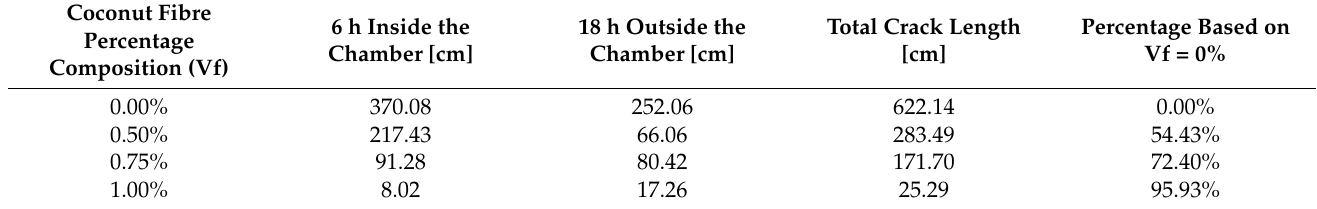
Figure 13. Graphical representation of Equation (1).